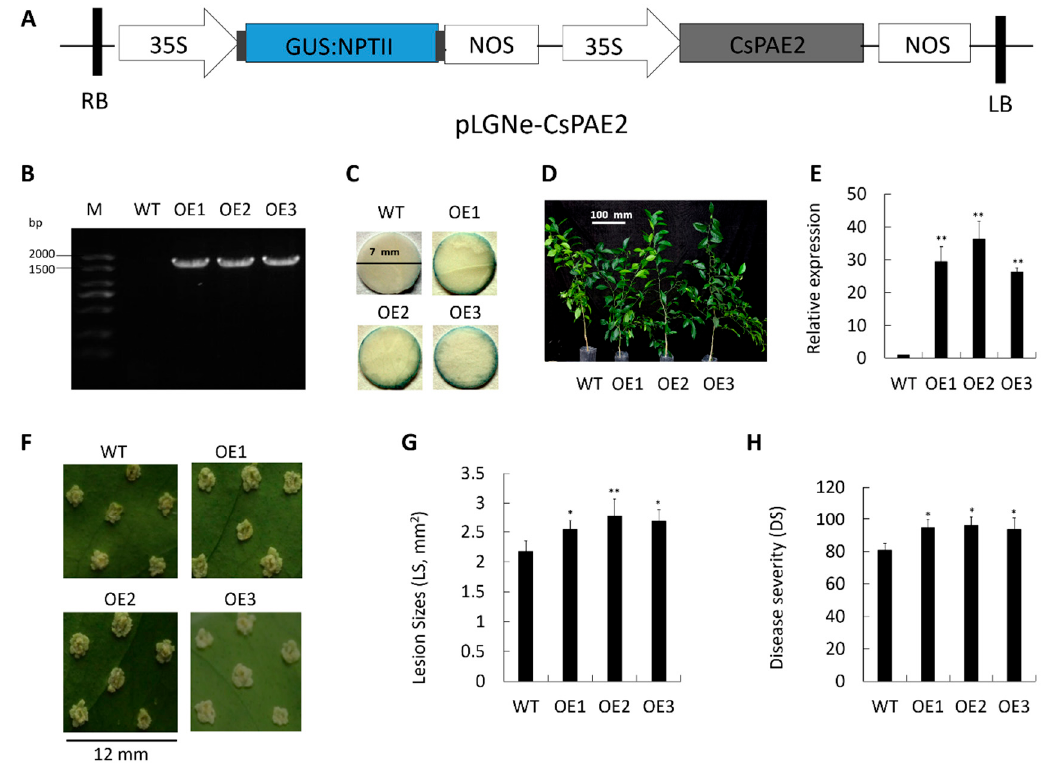
Figure 5. Assessment of Xcc responses in CsPAE2 overexpression plants and WT plant. ( A ) Plasmid pLGNe- CsPAE2 used for overexpression assay. NPTII, NptII gene; NOS, Nos terminator; GUS, glucuronidase; LB: left border; RB: right border. ( B ) PCR-mediated validation of transgenic plants. ( C ) GUS staining-mediated validation of transgenic plants. ( D ) Phenotypes of the transgenic plants. Scale bar = 100 mm. ( E ) The expression of CsPAE2 in the indicated plants was measured via qRT-PCR, with CsActin for the normalization. At 10 dpi, disease symptoms on the leaves of WT and transgenic plants inoculated with Xcc were assessed ( F ); lesion size (LS) ( G ) and disease severity (DS) ( H ) were assessed. In ( F ), the scale bar = 12 mm. WT plants served as controls for statistical testing. Data are means ± SEs ( n ≥ 3). Duncan’s multiple range test was used to compare data of OEs and WT, with three biological replicates per sample ( * p < 0.05; ** p < 0.01).